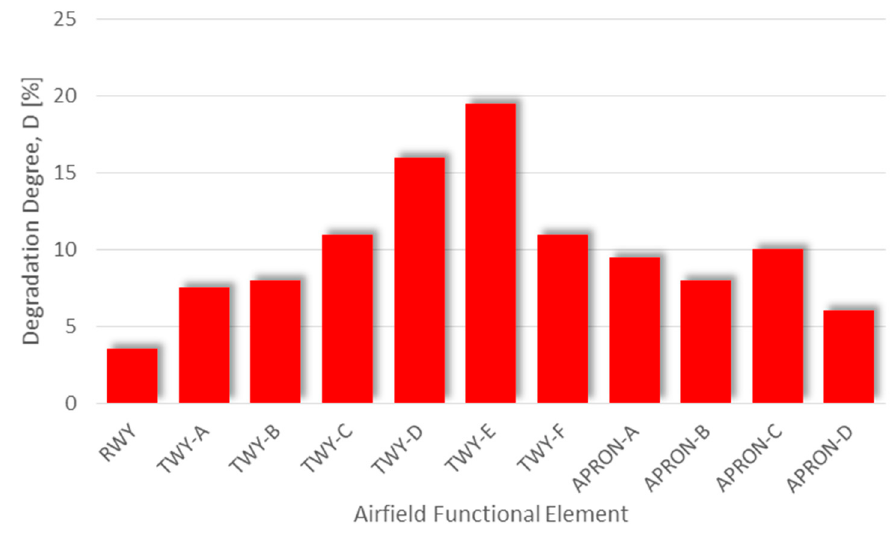
Figure 9. Results of pavement degradation.